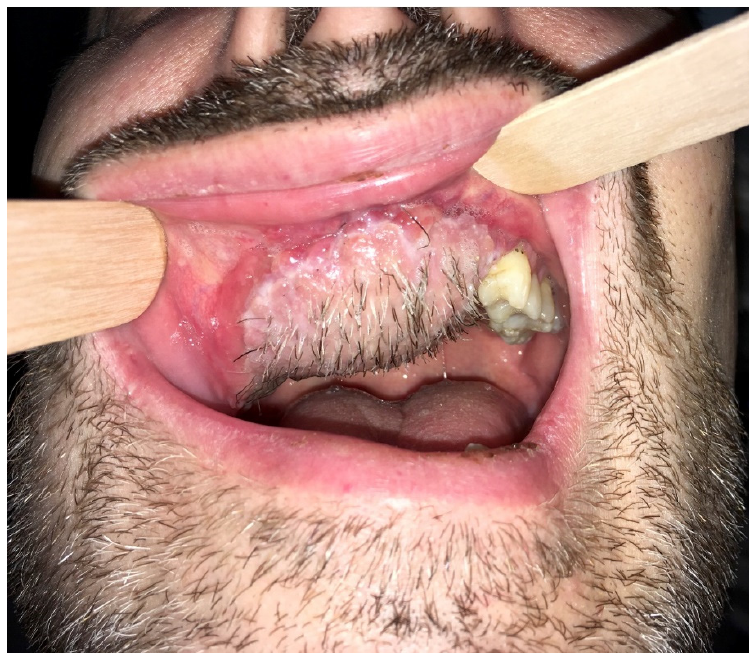
Figure 6. Postsurgical oral status after 45 days from surgery. The submental flap is perfectly integrated and the palate–maxillary gum completely healed in less than 60 days. Hair-bearing skin is present, which caused significant discomfort for the patient.